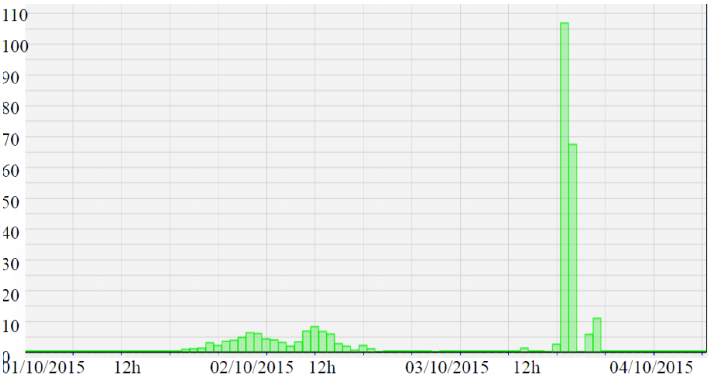
Figure 4. Hourly rainfall in Cannes (mm) from 00 UTC, 1 October 2015 and 12 UTC, 4 October 2015. National Weather Service (Meteo